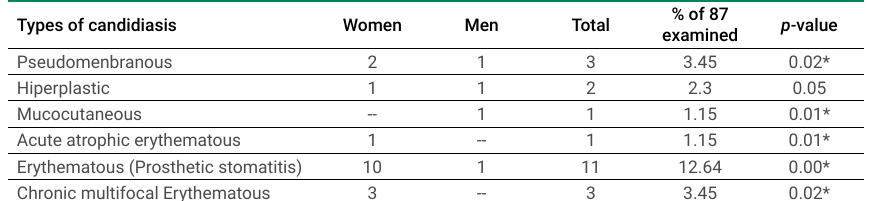
Table 1. Types of candidiasis 9 diagnosed in patients with lesions (n=21).